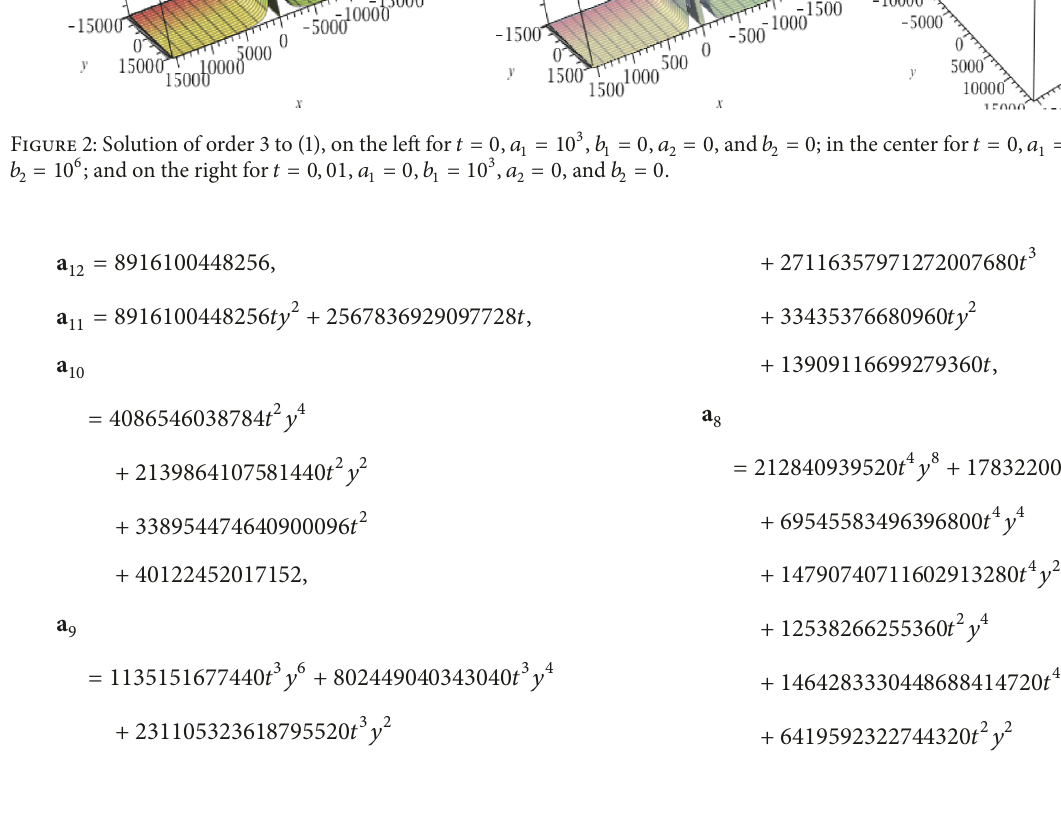
Figure 2: Solution of order 3 to (1), on the left for 𝑡 = 0 , 𝑎 1 = 10 3 , 𝑏 1 = 0 , 𝑎 2 = 0 , and 𝑏 2 = 0 ; in the center for 𝑡 = 0 , 𝑎 1 = 0 , 𝑏 1 = 0 , 𝑎 2 = 0 , and 𝑏 = 10 6 ; and on the right for 𝑡 = 0, 01 , 𝑎 2